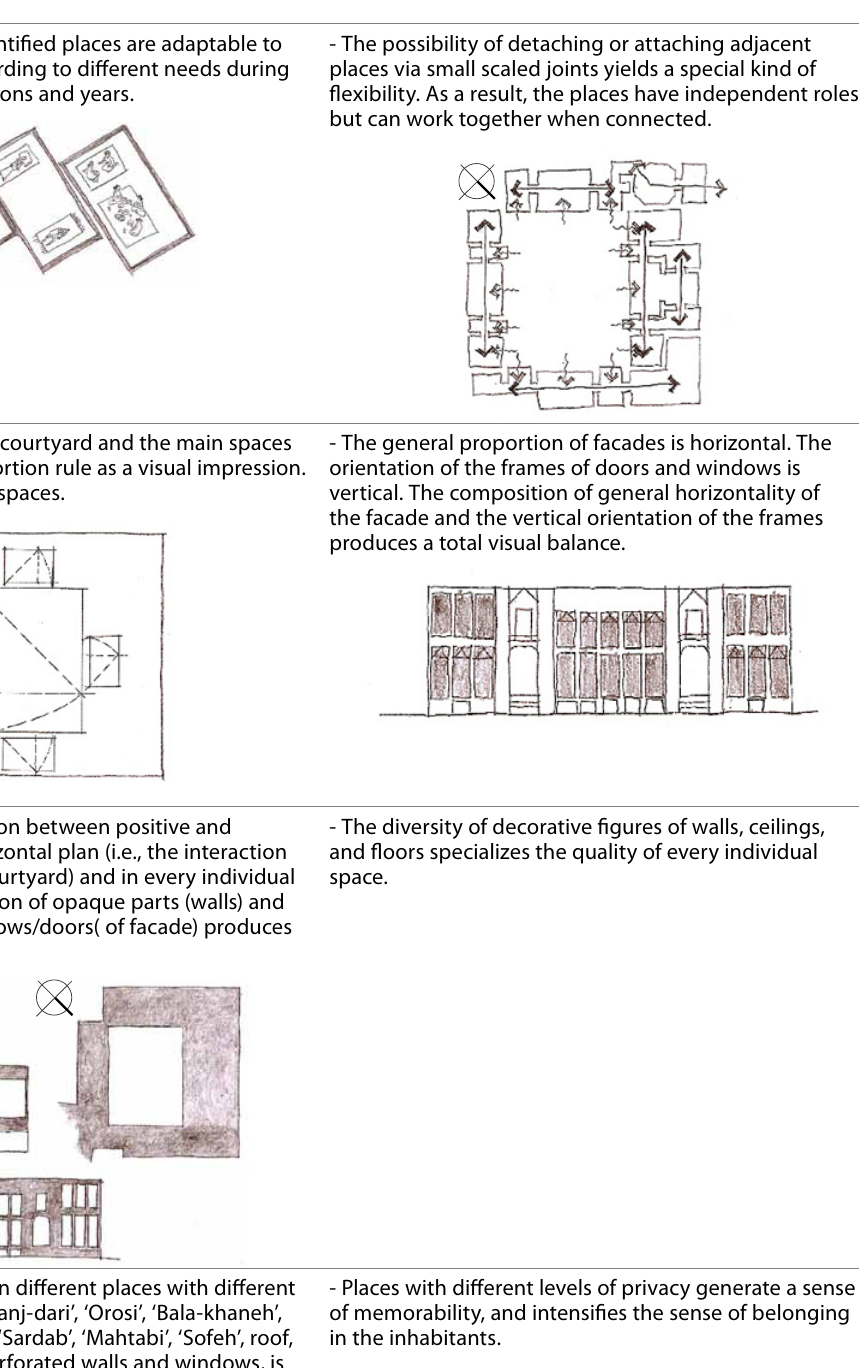
‘Dalan’) and levels (e.g., ‘Sardab’, ‘Mahtabi’, ‘Sofeh’, roof, courtyard), simple or perforated walls and windows, is effective in providing different levels of privacy.